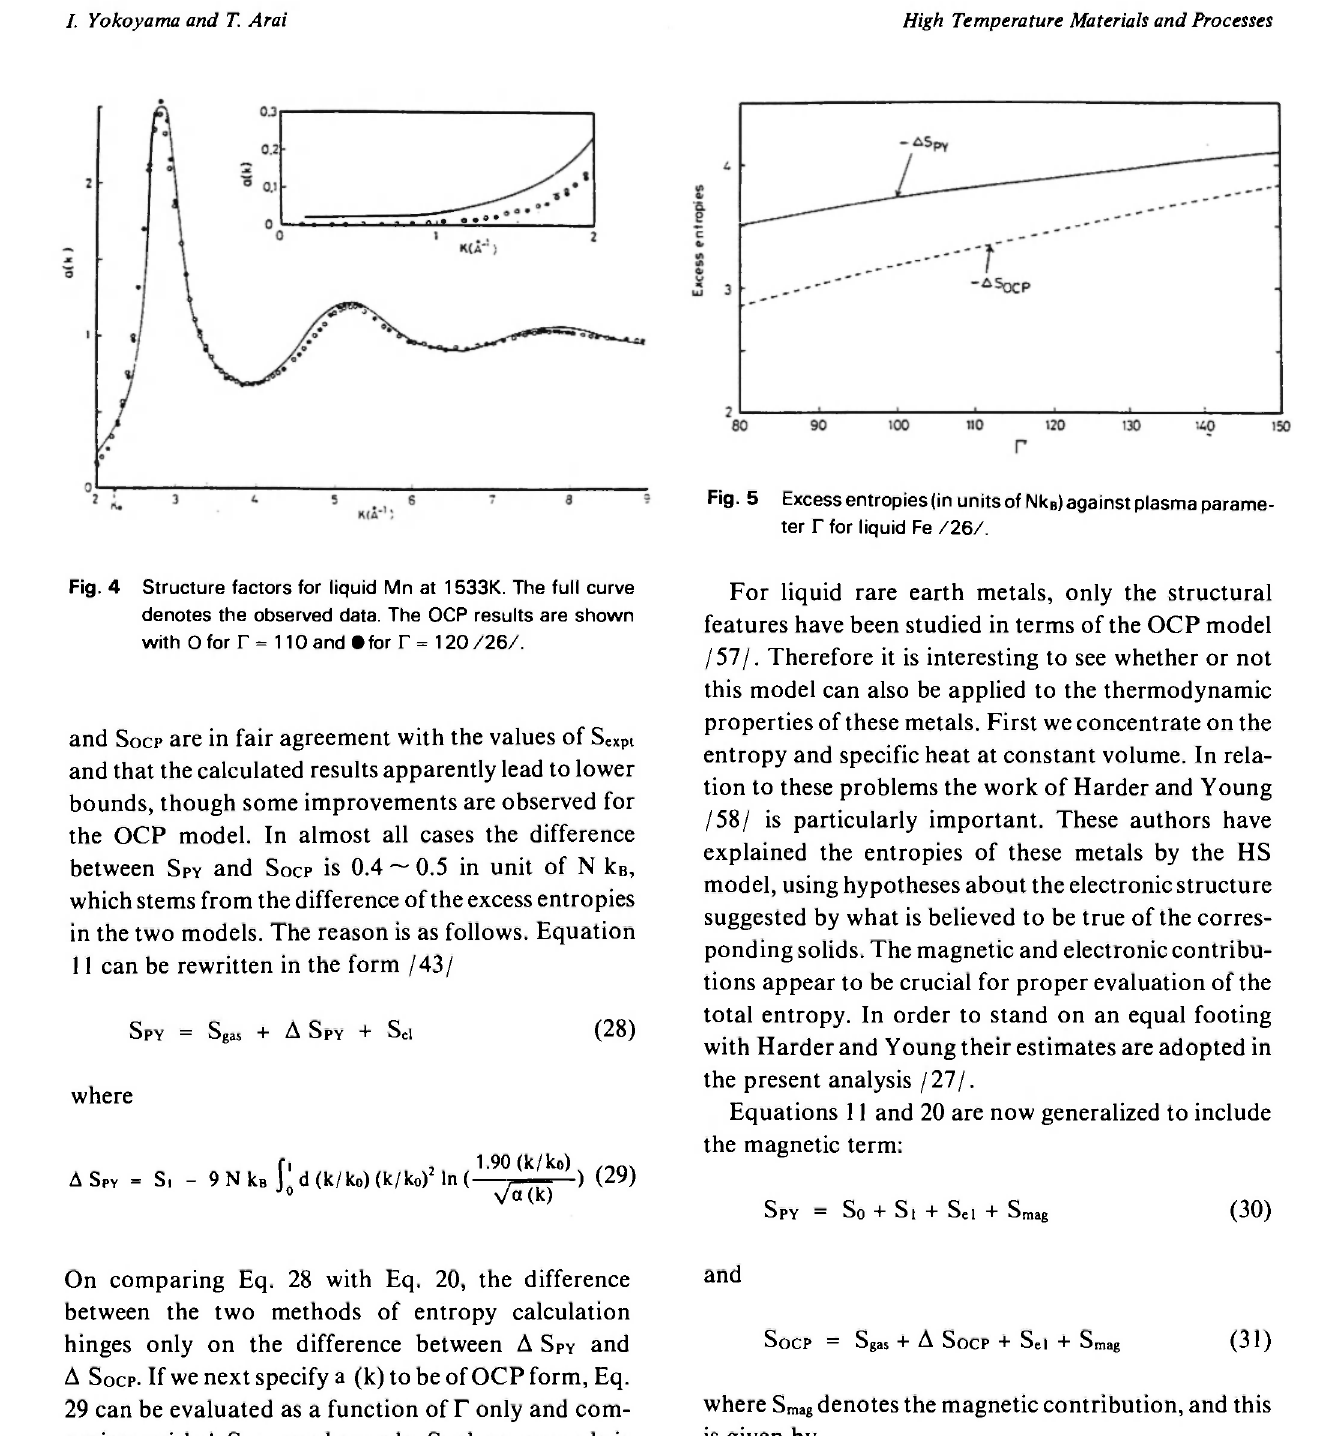
Fig. 5 Excess entropies (in units of Nk B ) against plasma parame- ter Γ for liquid Fe